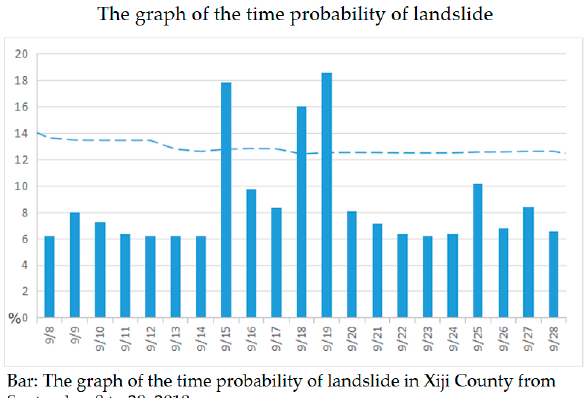
Figure 20. The graph of the time probability of landslide. The bar is the graph of the time probability of landslide in Xiji County from 8–28 September 2018. The broken line is the graph of dangerous time probability of landslide in Xiji County from 8–28 September 2018.